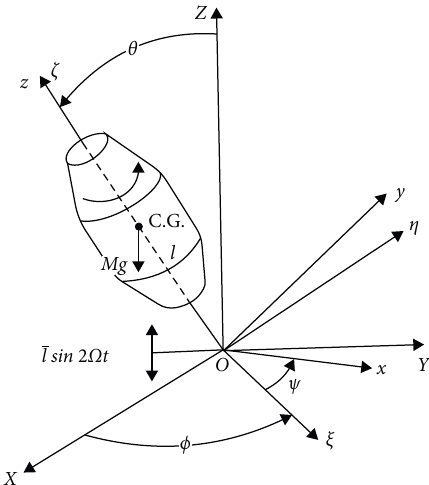
Figure 1: Schematic diagram of a symmetrical gyroscope [12,